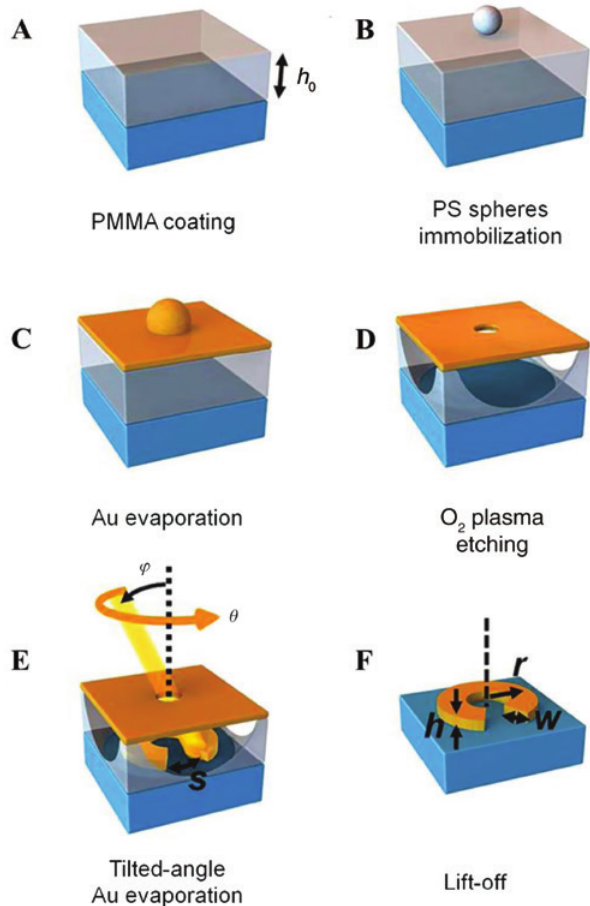
Figure 13: Fabrication scheme. (A) Deposition of sacrificial PMMA layer; (B) deposition of polystyrene spheres in an arbitrarily distributed arrangement; (C) evaporation of oxygen plasma resistant Au-mask; (D) removing polystyrene spheres with ultrasonic bath and subsequent isotropic dry etching leads to extended holes in PMMA layer; (E) evaporation of the structures by tilted angle evaporation (polar rotation angle θ , azimuthal tilt angle ϕ ); (F) lift-off of the sacrificial PMMA layer, adapted from Ref.